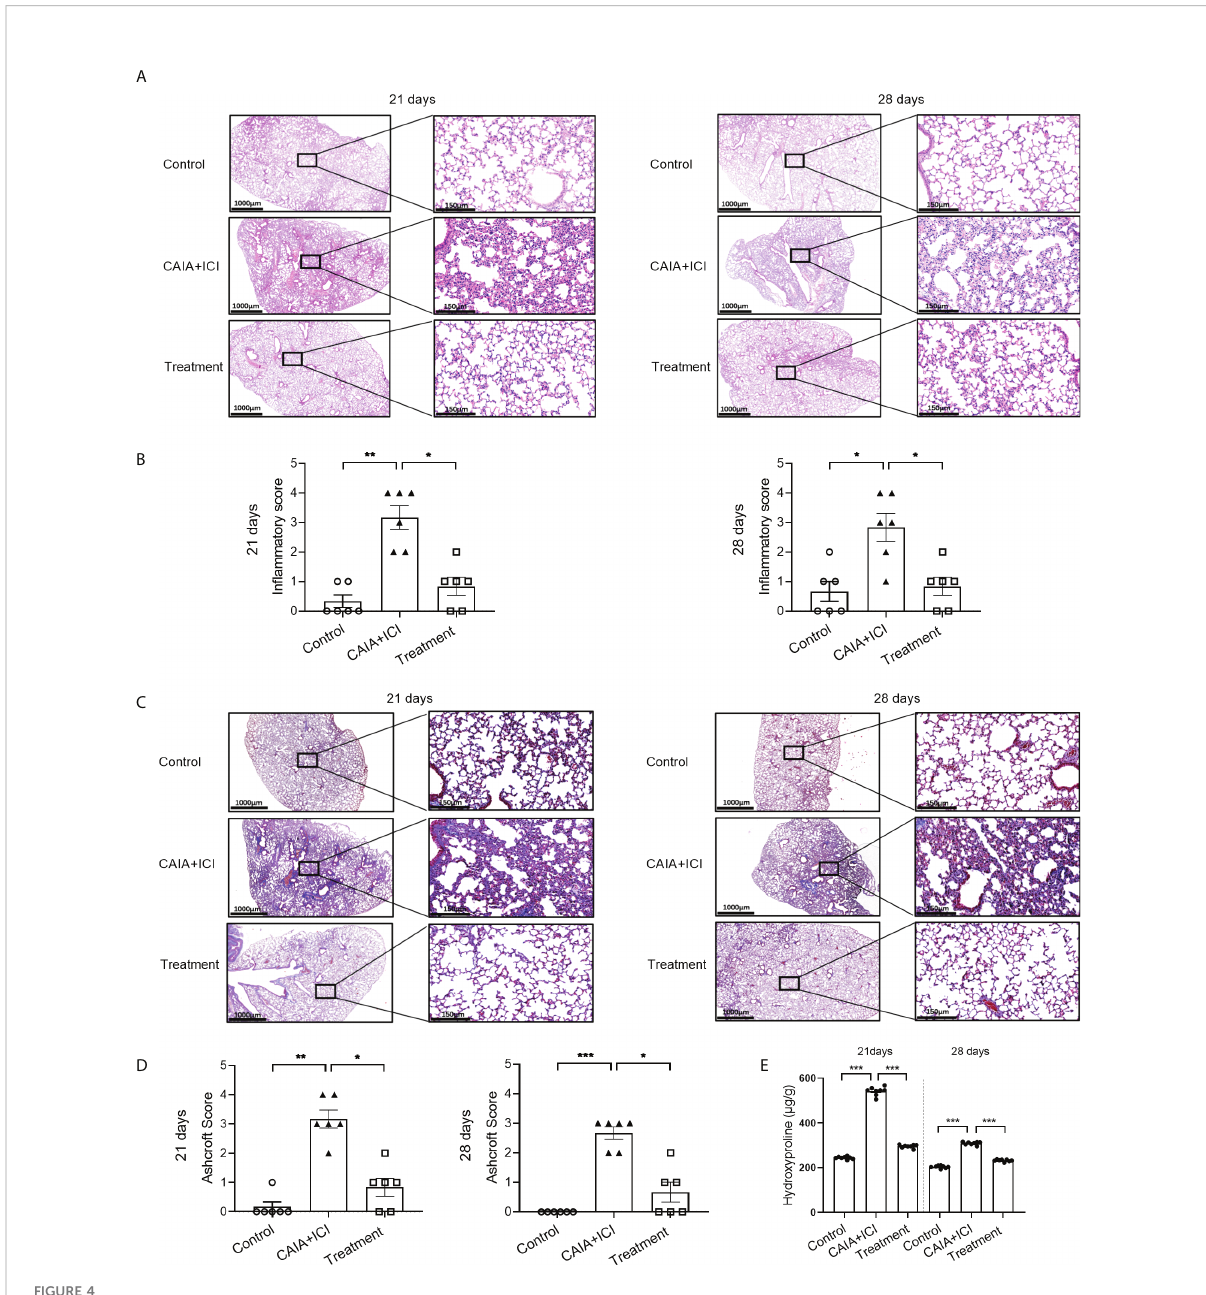
FIGURE 4 Anti-TNF- a treatment mitigates the degrees of lung in fl ammation in mice. (A, C) Representative images of lung tissue sections from mice on day 21 and 28 post induction after HE and Masson staining, respectively. (B) Lung in fl ammatory scores in mice. (D) Lung Ashcroft scores in mice. (E) The contents of lung hydroxyprolines in mice on day 21 and 28 post induction. Data are representative images or presented as means ± SEM of each group (n=6) of mice. Statistical signi fi cance was calculated by the Kruskal-Wallis H test * p < 0.05, ** p < 0.01, *** p <